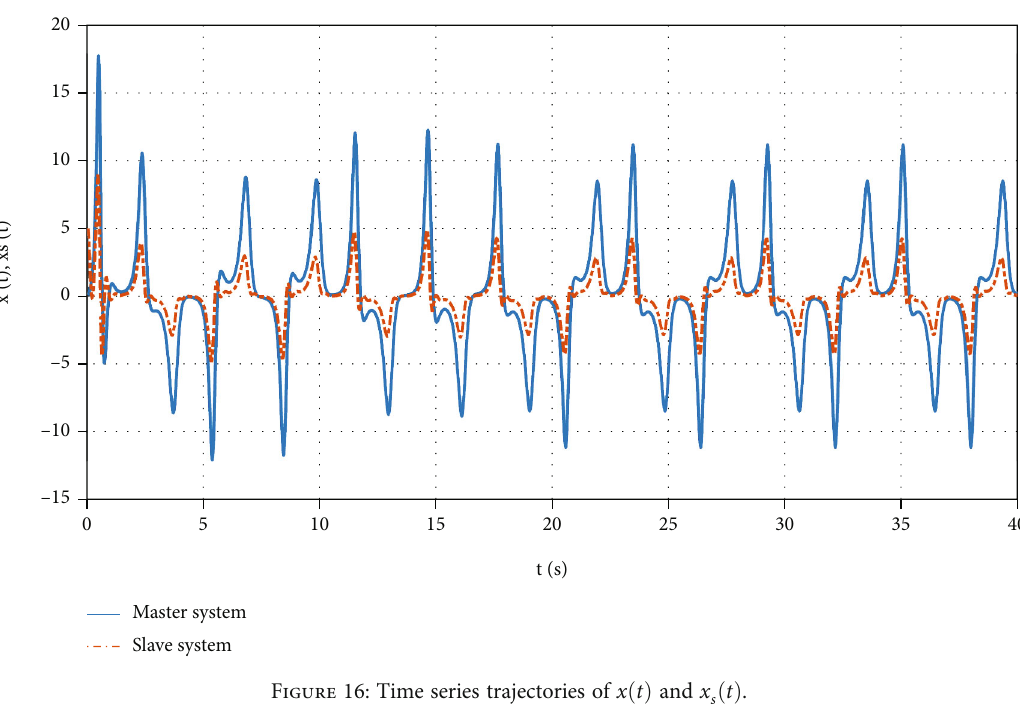
Figure 16: Time series trajectories of x ð t Þ and x